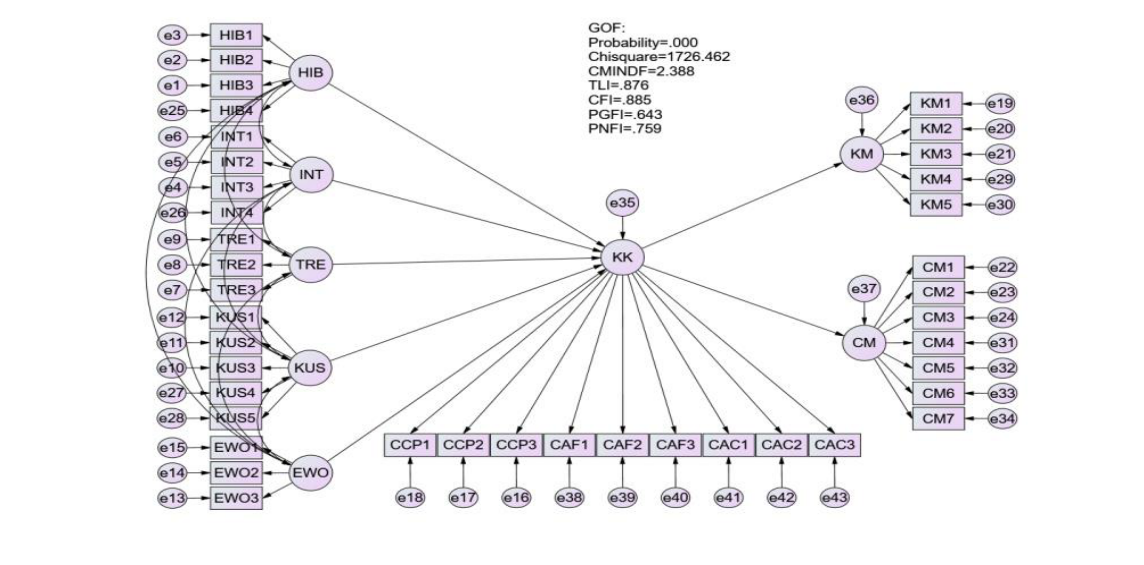
Figure 2: Diagram and path